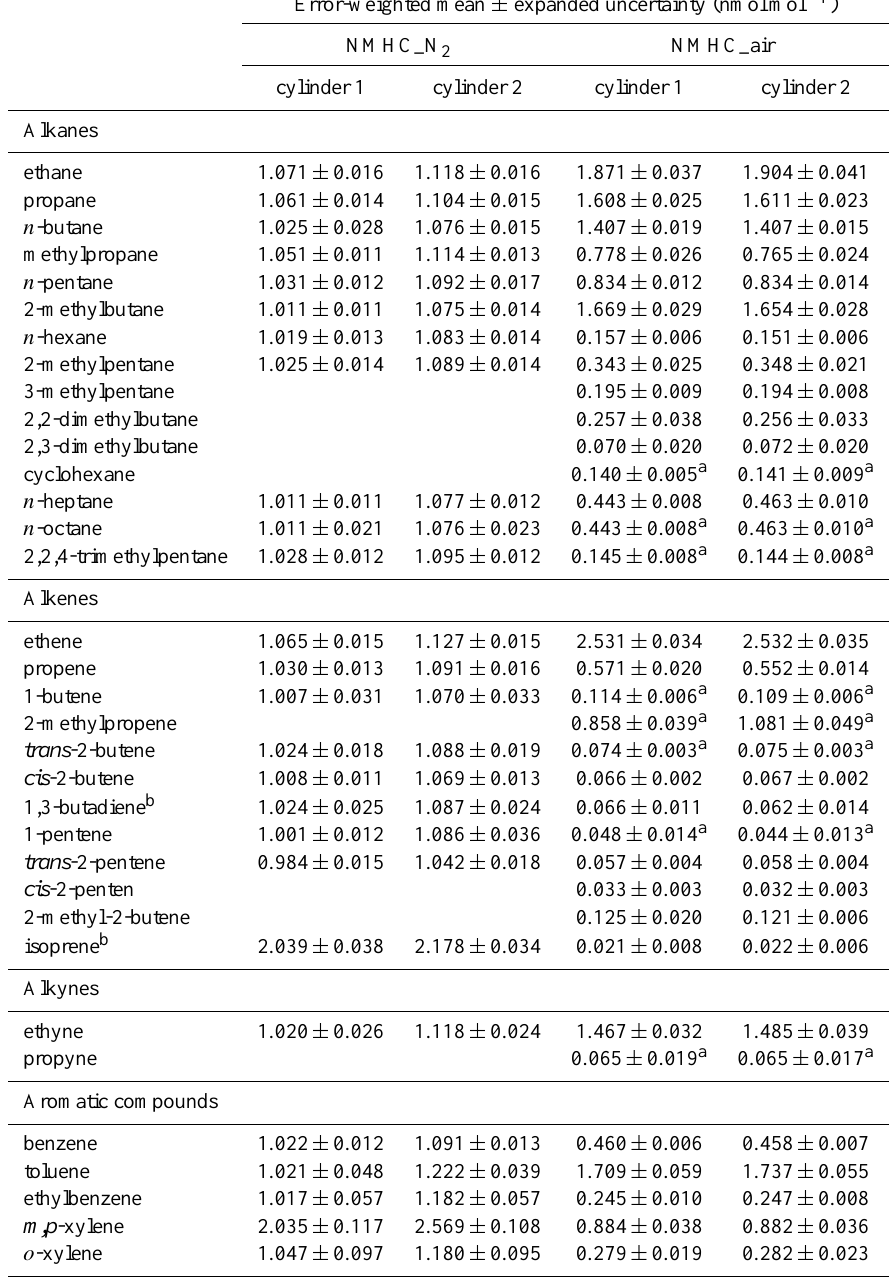
Table 1. Assigned mole fractions (error-weighted means with expanded uncertainties) for NMHC_N 2 and NMHC_air (nmolmol − 1